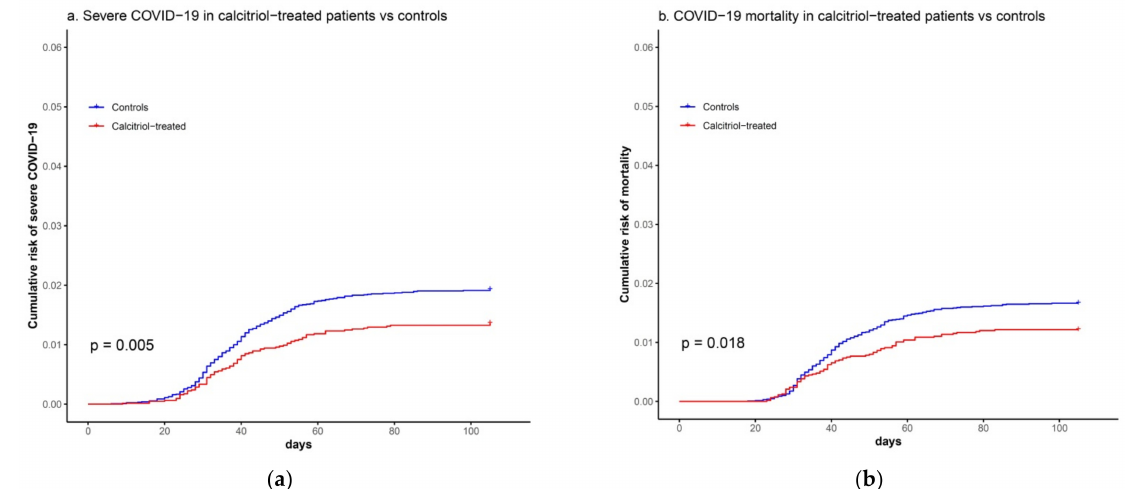
Figure 2. Kaplan–Meier plots showing: ( a ) Cumulative risk of severe COVID-19 (composite outcome of need for non- invasive mechanical ventilation, orotracheal intubation, mechanical ventilation, intensive care unit admission or COVID-19 mortality) between 25 February 2020 and 7 June 2020 in patients supplemented with calcitriol or matched controls or ( b ) COVID-19 mortality in patients supplemented with calcitriol or matched controls during the same period.